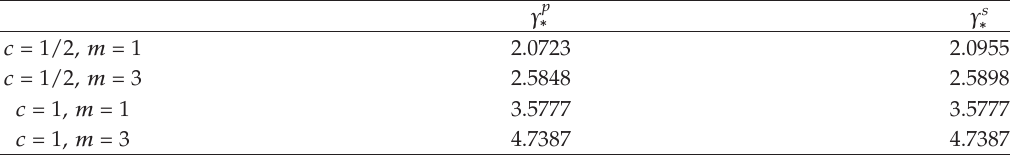
Table 2: Some typical